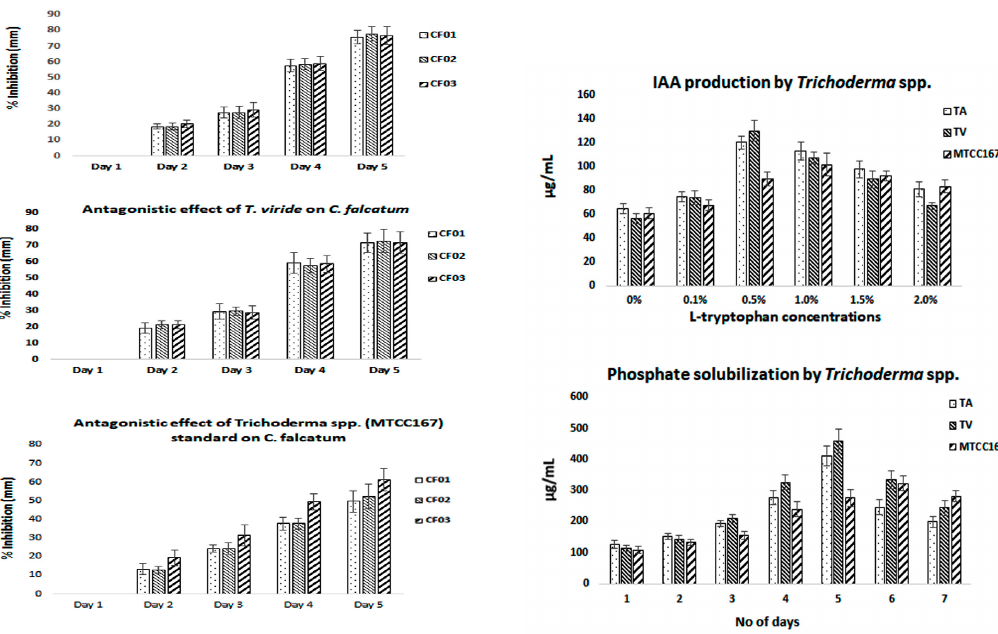
Fig. 6. Antagonistic activity of TS against CF Fig. 7. Plant growth promoter activity of